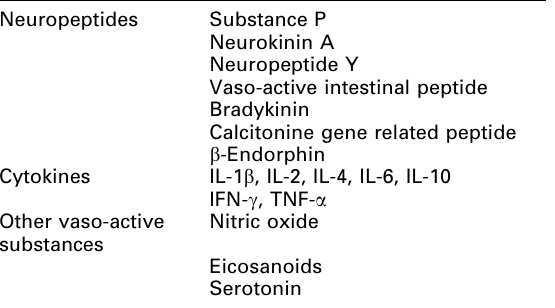
Table 2. Inflammatory mediators reported in